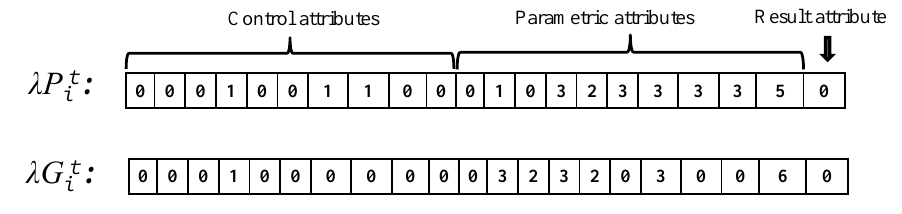
Figure 8. A sample of performing the difference operator ( ⊖ ).